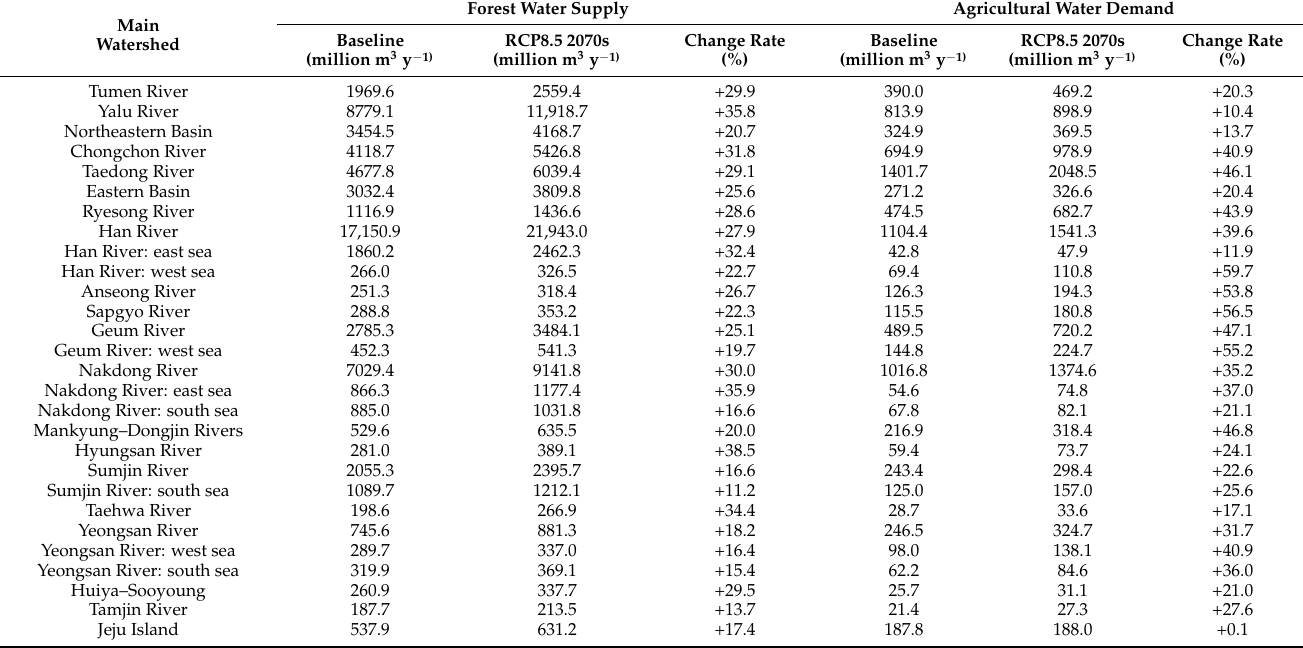
Figure 8. Water supply–demand balance under climate change at the main watershed level: ( a ) base- line period and ( b ) RCP8.5 2070s. Table 4. Agricultural water demand and forest water supply under climate change at the main watershed